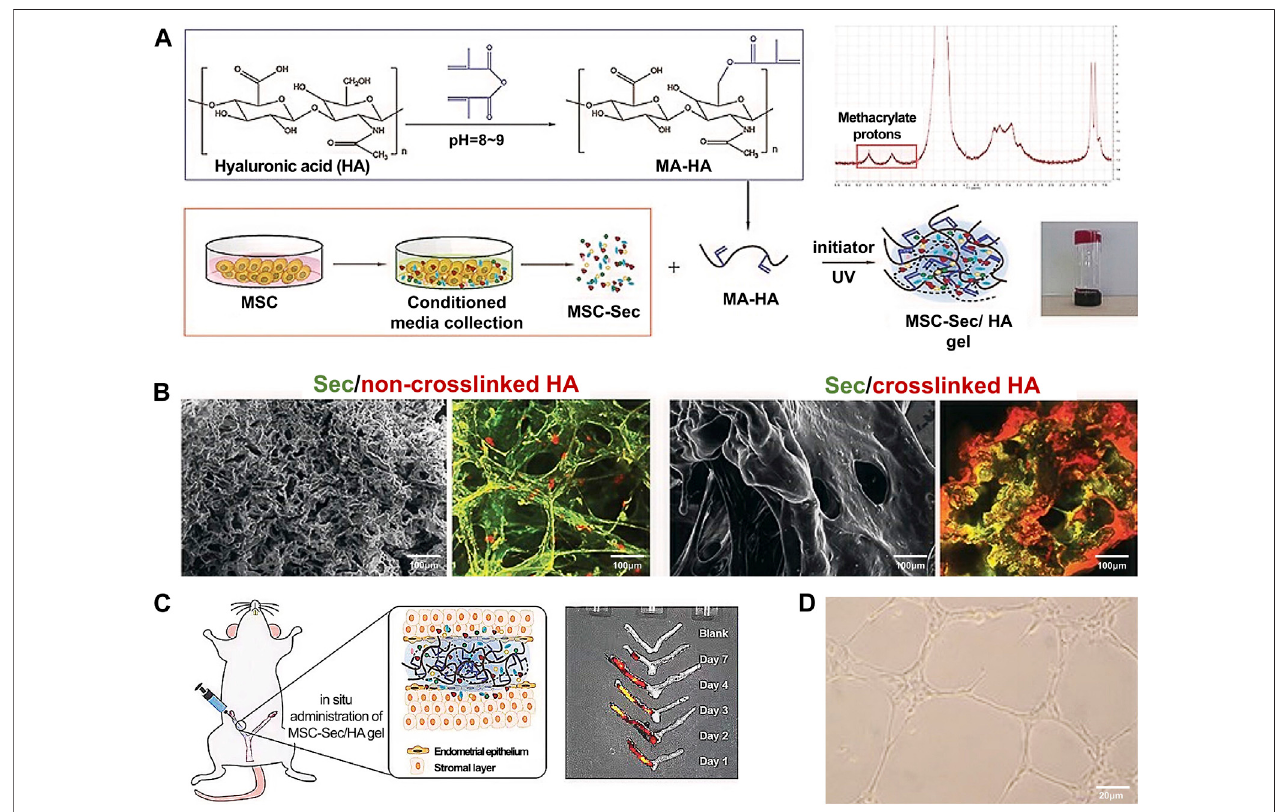
FIGURE 4 | Fabrication and characterization of MSC-Sec-loaded crosslinked HA gel. (A) Schematic showing the synthesis of MSC-Sec-loaded, crosslinked HA gel and the state ofHAgel at room temperature when thebottle isupside down. (B) RepresentativeSEM and color-depth projectionconfocalimages ofMSC-Sec/non- crosslinked HA and MSC-Sec/crosslinked HA; green represents MSC-Sec, red represents HA. (C) MSC-Sec/HA gel injection and a rodent model of endometrial injury. (D) The tube-formation ability of human umbilical vein endothelial cells is enhanced in the MSC-Sec-treated group. Reproduced with permission (Liu et al., 2019). Copyright 2019 WILEY-VCH Verlag GmbH & Co. KGaA,